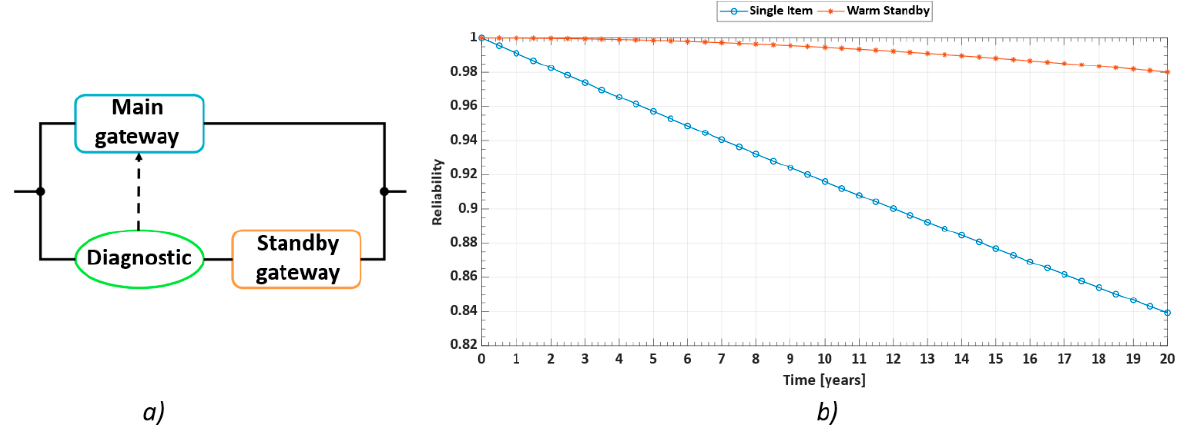
Figure 4. Proposed solution to achieve gateway fault tolerance: ( a ) illustrates the Reliability Block Diagram of the warm standby configuration.; ( b ) comparison between the reliability trends of a single gateway (blue curve) and of a fault tolerant warm standby comprising two gateways and a diagnostic system (red curve).